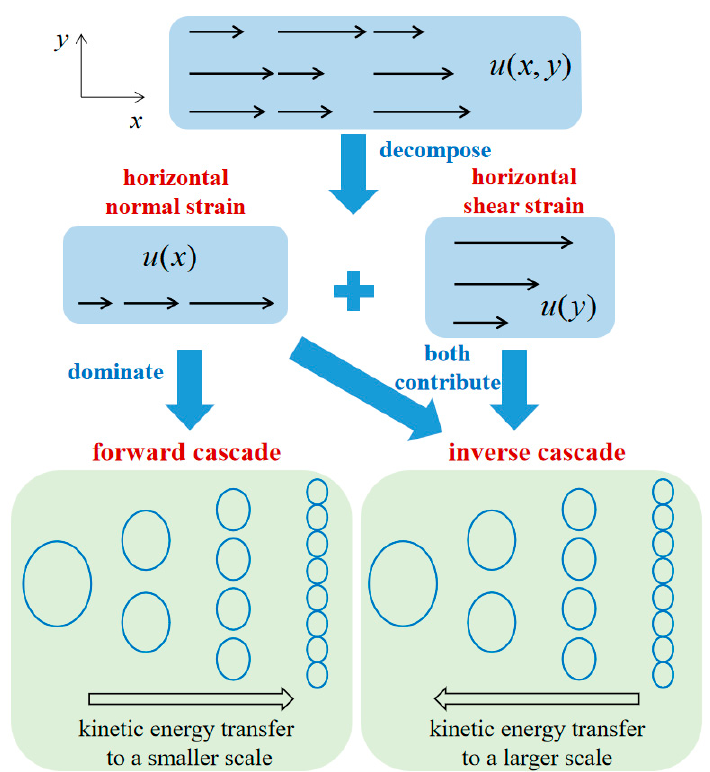
Figure 11. The role of horizontal normal strain and shear strain of flow in the kinetic-energy cascade in the upper ocean. We show here an arbitrary pure zonal flow u , decomposed into flows containing horizontal normal strain and shear strain. In the North Pacific regions we considered here, forward kinetic-energy cascade is dominated by the former, whereas the inverse cascade comes from both.